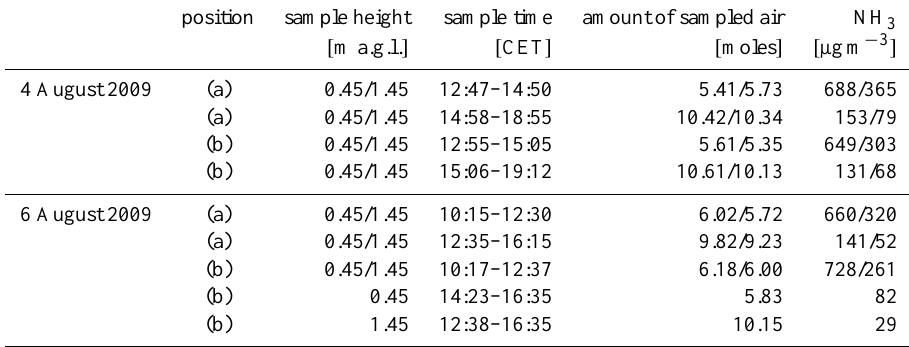
Table 1. Impinger measurements; positions as displayed in Fig.